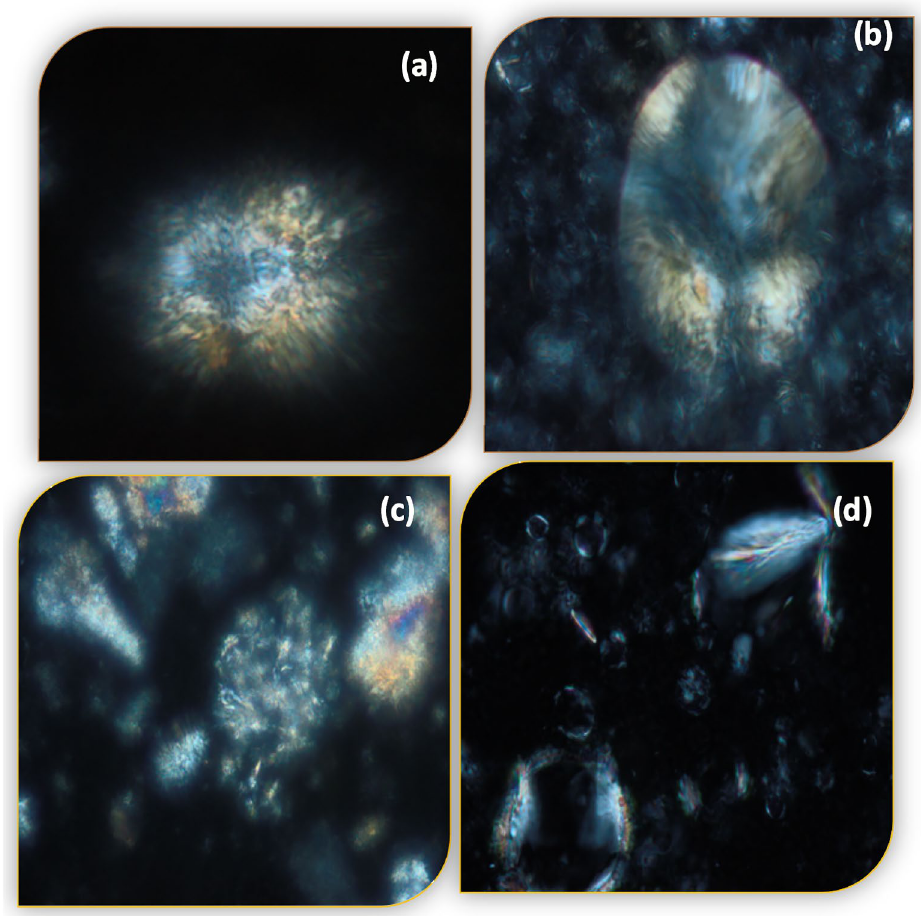
Figure 8. PLM of functional gummies based-spreadable oleogel ( a ) gummy P Cho ( b ) gummy D, ( c ) gummy P Car , and ( d ) gummy